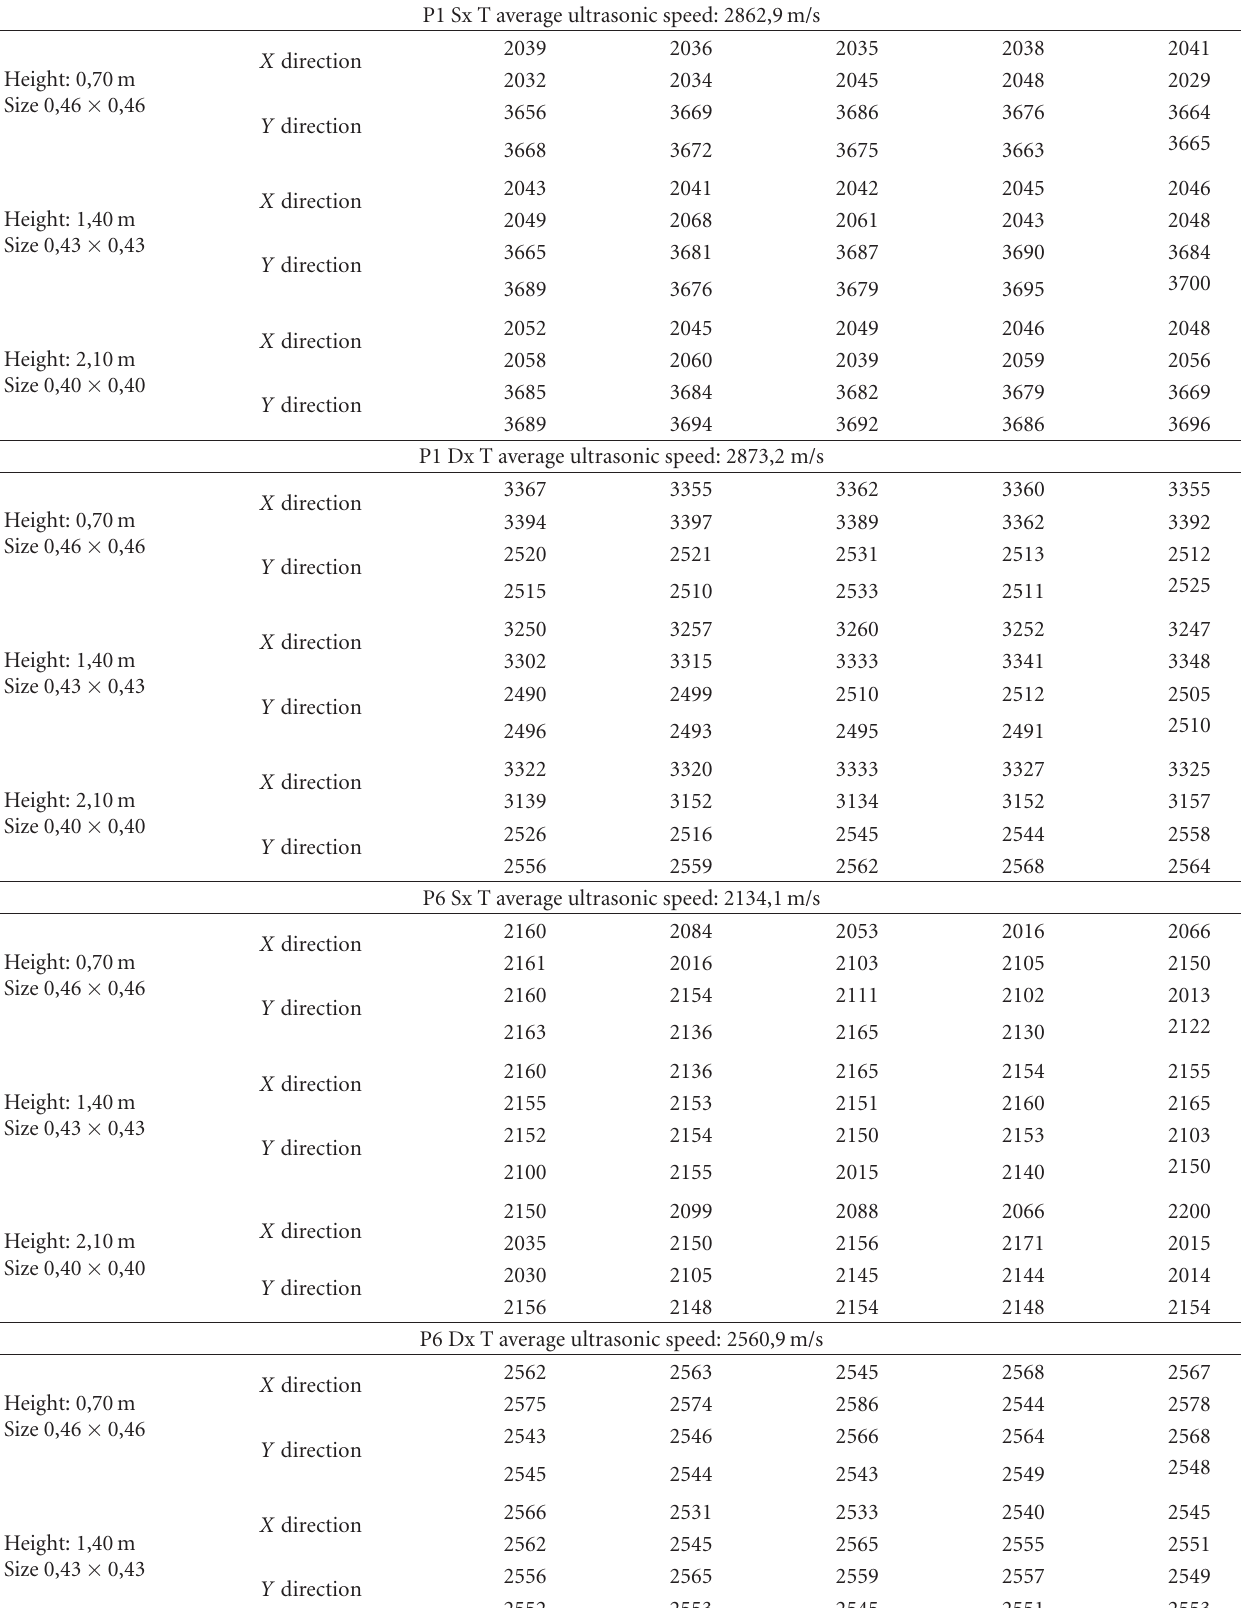
Table 2: The value of ultrasonic